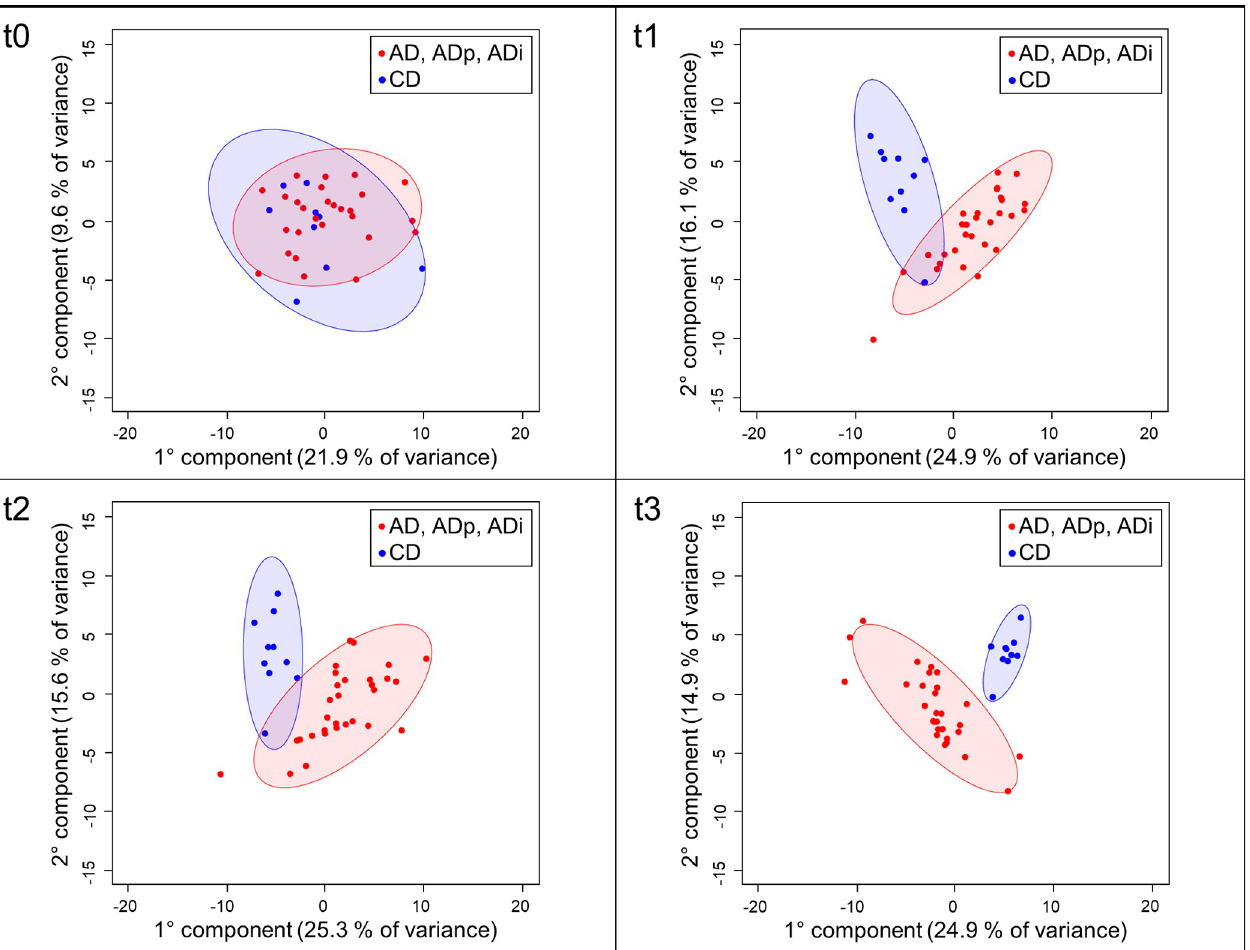
Fig 2. PCA analysis of the 1 H NMR spectra of serum samples. Data present the time point before the feed change (t0) and time points 1–3 months after the feed changes (t1–t3) for all feeding groups (AD, ADp, ADi, CD).